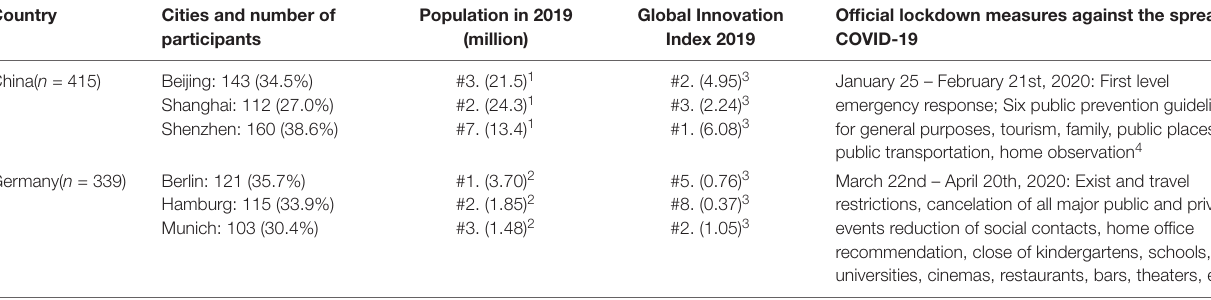
TABLE 2 | Comparability of the participating cities. Country Cities and number of